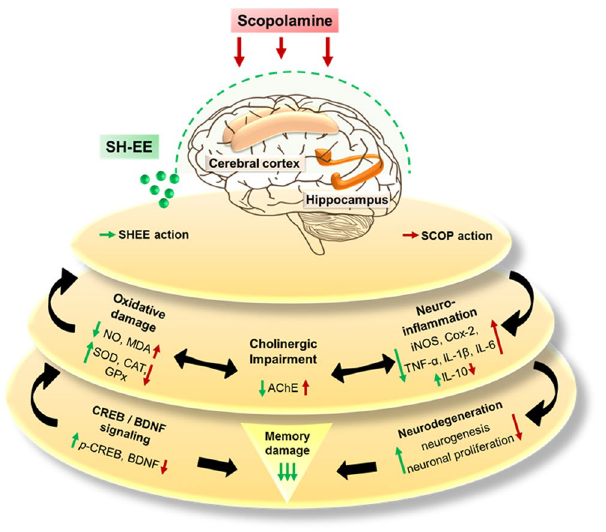
Figure 8. Schematic representation on the ameliorative potential of SE-EE at its molecular mechanistic events associated with scopolamine induced amnesic mice model (the base image of the brain outline in this figure was adapted from